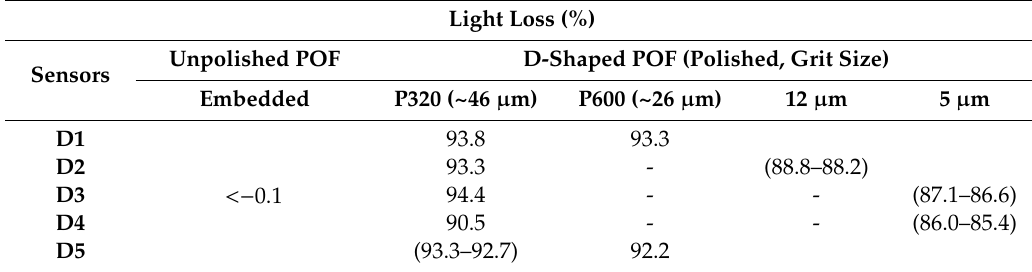
Table 1. Calculated light losses (%) in di ff erent production stages of the D-shaped POF sensors (relative to the unpolished POF